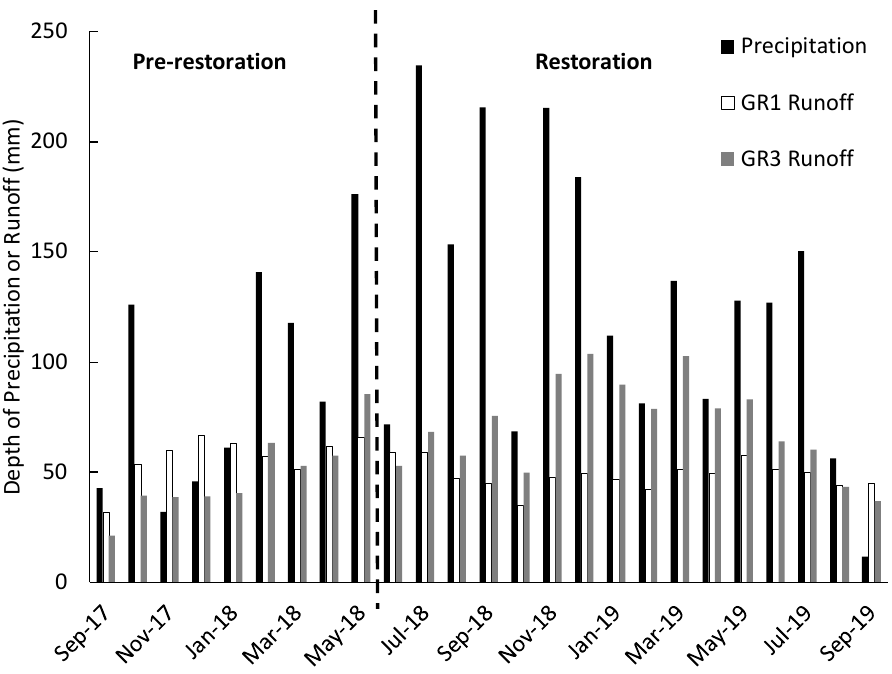
Figure 6. Monthly precipitation and runoff/streamflow for the pre- and during-restoration phases of the project for upstream (GR1) and downstream (GR3) sites.